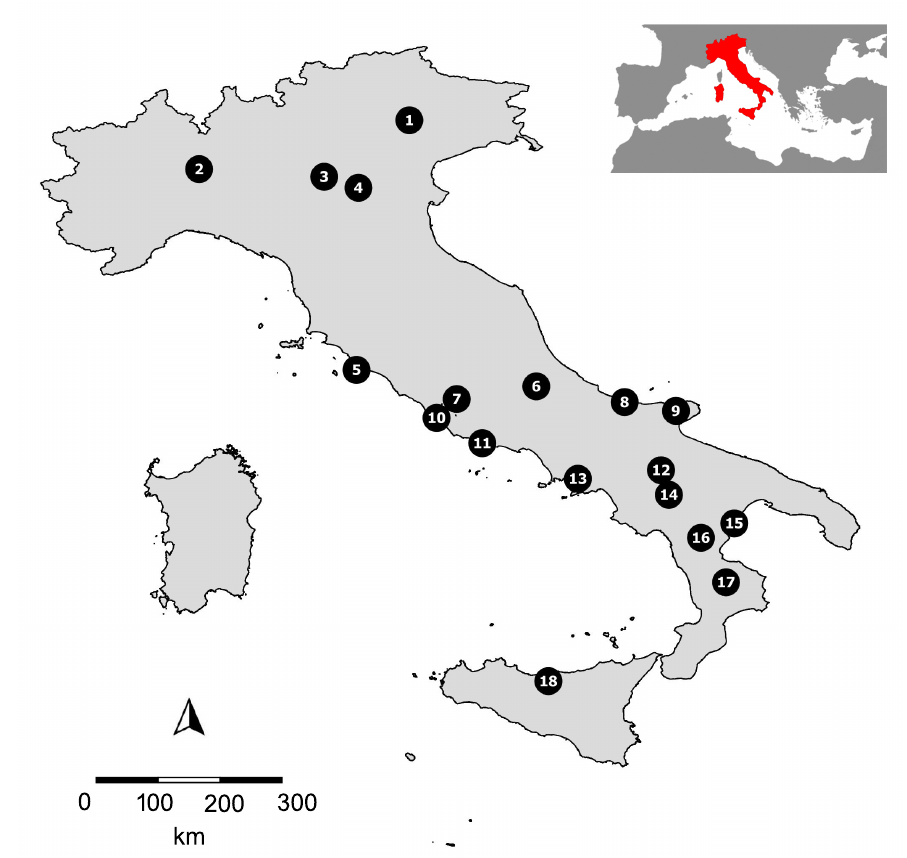
Figure 1. Location of Italian reserves considered in this study. The inset shows the location of Italy (in red) within the Mediterranean. 1: Vincheto di Celarda Nature Reserve, 2: Ticino Regional Park, 3: Bosco Fontana Nature Reserve, 4: Isola Boscone Nature Reserve, 5: Burano Nature Reserve, 6: Pescara Spring Nature Reserve and adjacent areas in the Valle Peligna, 7: Inviolata Archeological and Nature Park, 8: Foce Saccione Site of Community Importance, 9: Gargano National Park plus Isola Varano Nature Reserve, 10: Castelporziano Presidential Estate and Castelfusano Urban Park, 11: Circeo National Park, 12: Vulture Natural Park, 13: Vesuvius National Park, 14: Pantano di Pignola Reserve, 15: Policoro Reserve, 16: Pollino National Park, 17: Sila National Park, 18: Madonie Regional Natural